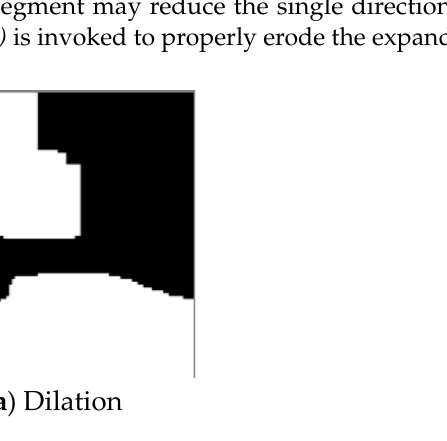
Figure 10. Effects of dilation and erode processes. The function cv2.findContours() is utilized to calculate the areas of all blocks, the largest ones of which, selected through the function sorted() , represents the contour-of-interest of the image. As represented in Figure 11a, the area marked in red is the largest part, for which the function cv2.fitLine() is used to get the unit vector of the fitting line, clearly overlapped on the original image, as depicted in Figure 11b.